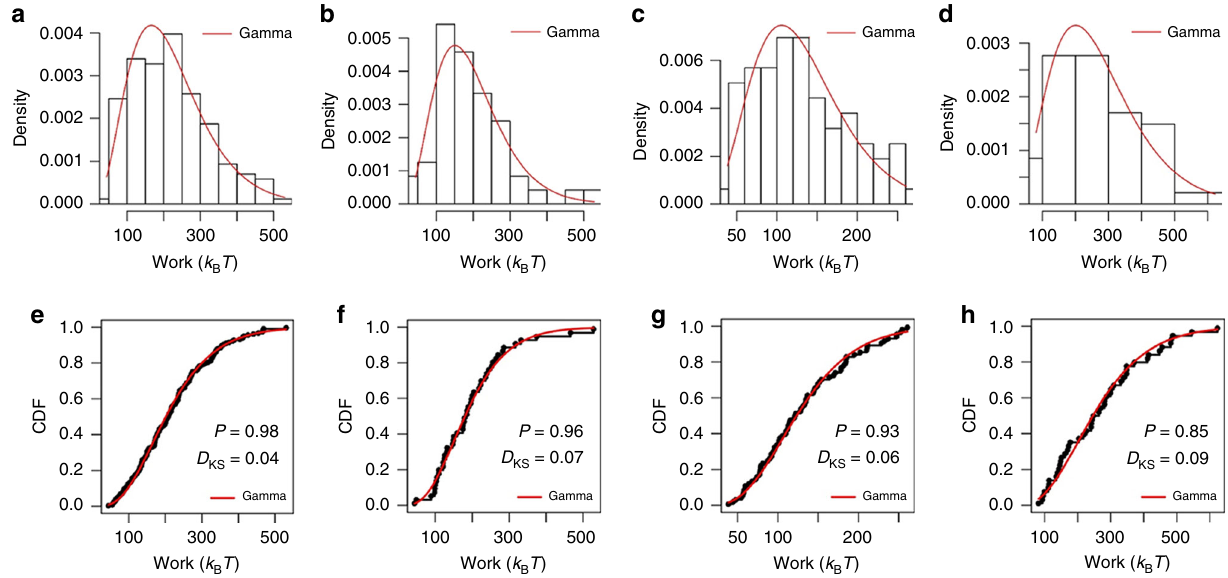
Fig. 2 The statistics of gamma fi tting. a – d Histograms of work values fi tted with gamma distribution for datasets A, B, C, and D, respectively. e – h The empirical cumulative distribution function (CDF) comparing to theoretical gamma distribution for datasets A, B, C, and D, respectively. D KS is the Kolmogorov – Smirnov test statistic. P is the P-value representing the likelihood of observing the test statistic.